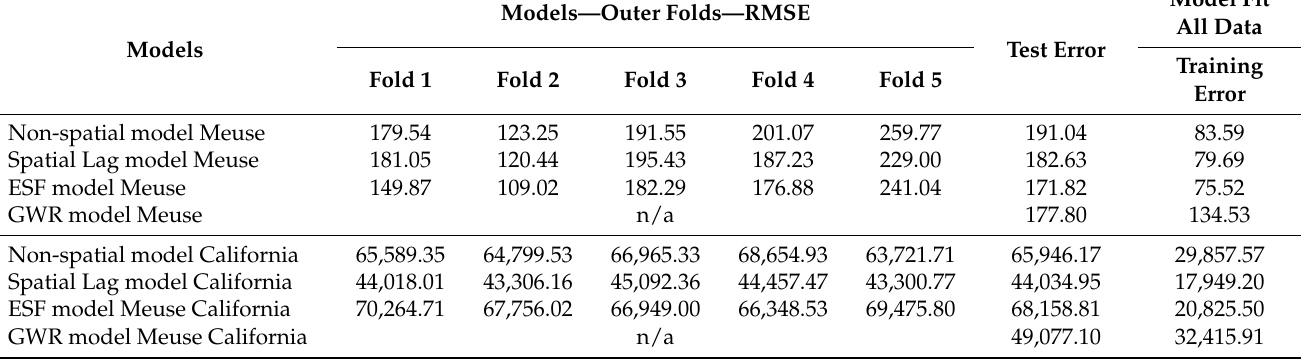
Table 5. RMSE—Training and Testing Errors. For the RF models test error is the average of the RMSE for each fold, and for the GWR models test error is the RMSE of the test data. Training error is the RMSE of the fit for all data